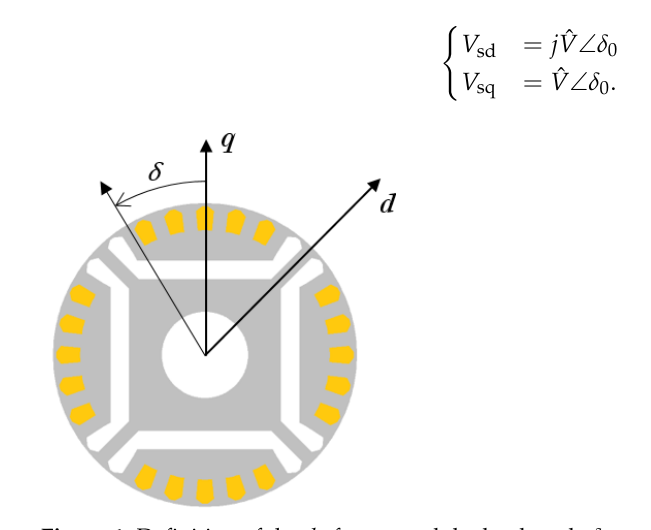
Figure 1. Definition of the dq frame, and the load angle δ